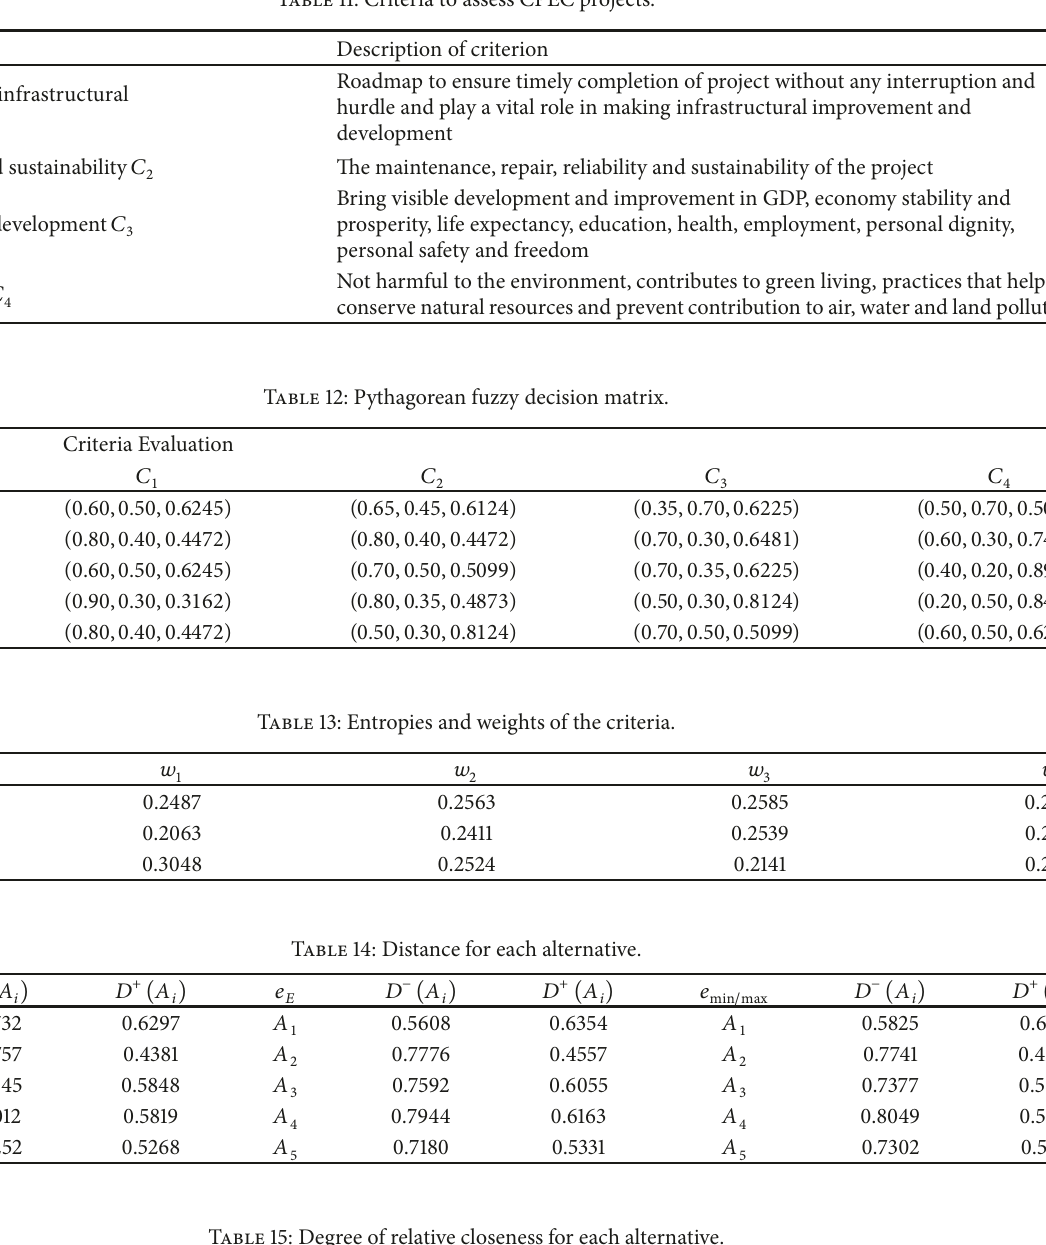
Table 11: Criteria to assess CPEC projects.